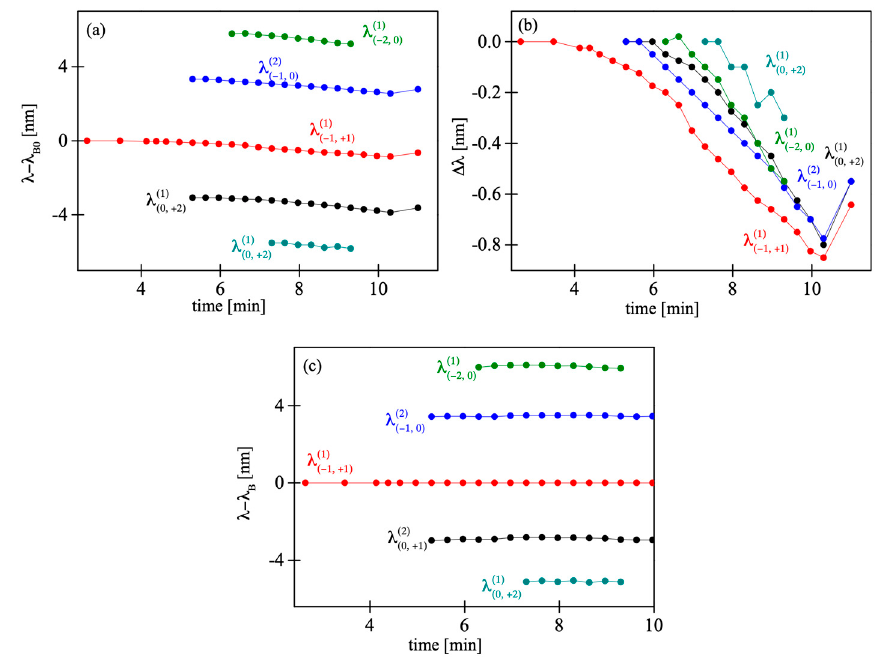
Figure 7. The relative position of the peaks as a function of the irradiation time for the tilt angle ϕ = 0.77°. All the peaks shifted towards shorter wavelengths with increasing irradiation time, Figure